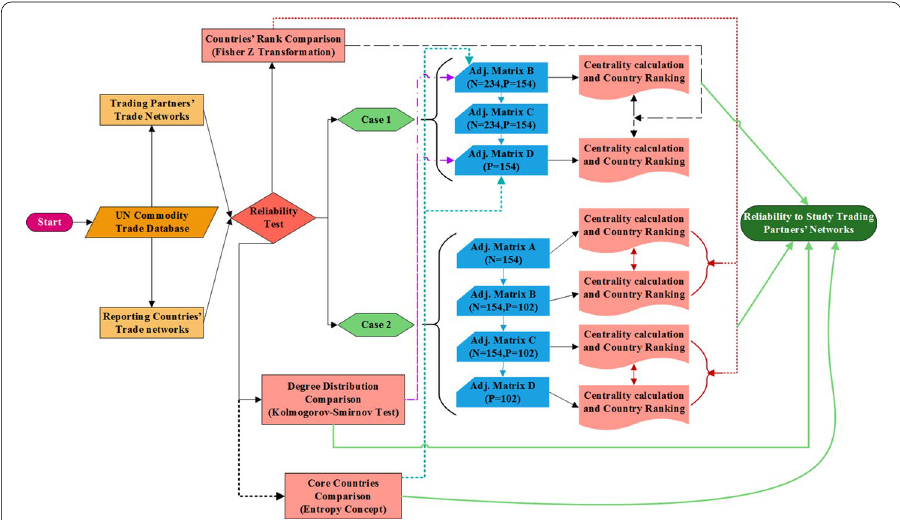
Fig. 1 Simplified outline of the proposed network approach to study the robustness of trading partners’